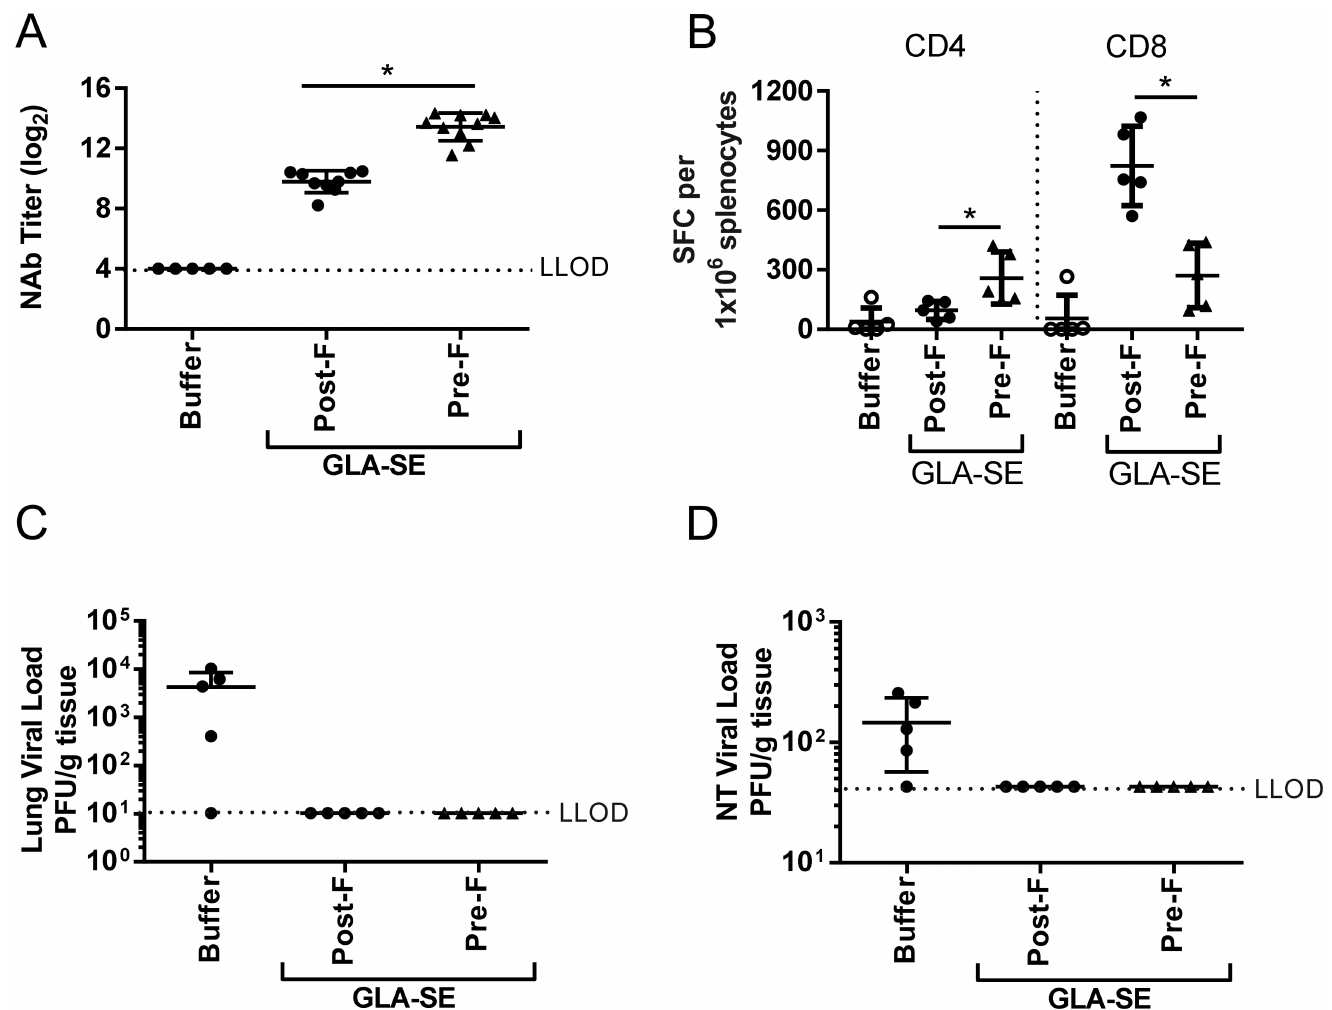
Fig 4. Immunogenicity and protection from viral challenge of pre-RSV + GLA-SE in young, seronegative mice. Young(7 weeks old) BALB/c mice (n = 5 to 10 per group) were immunized i.m. at day 0 and day 21 with buffer alone,RSV F pre- and post-conformation at 0.3 μ g +/- GLA-SE (2.5 μ g/2%) adjuvant. At day 35, animalswere challenged i.n. with 10 6 PFU of wt RSV A2. (A) Prior to challenge (day 34), sera were harvestedand NAb titers were evaluatedusing a microneutralizationassay. Data is presented as the log 2 dilutionof serum that provides50% reductionin viral entry with a LLOD of 4 indicatedby a dashed line. (B) 4 days post-challenge(day 39), splenocyteswere isolated and stimulated for 24 h with RSV F specific CD4 T-cell and CD8 T cell epitopes.The numberof IFN γ secretingcells per 10 6 splenocyteswas determined by ELISPOT. (C) Lung and (D) nasal turbinates viral loads were measuredby plaqueassay. Group means ± SD of individualmice are shown. For statistical analyses, aged and youngmice were compared. * , P < 0.05.